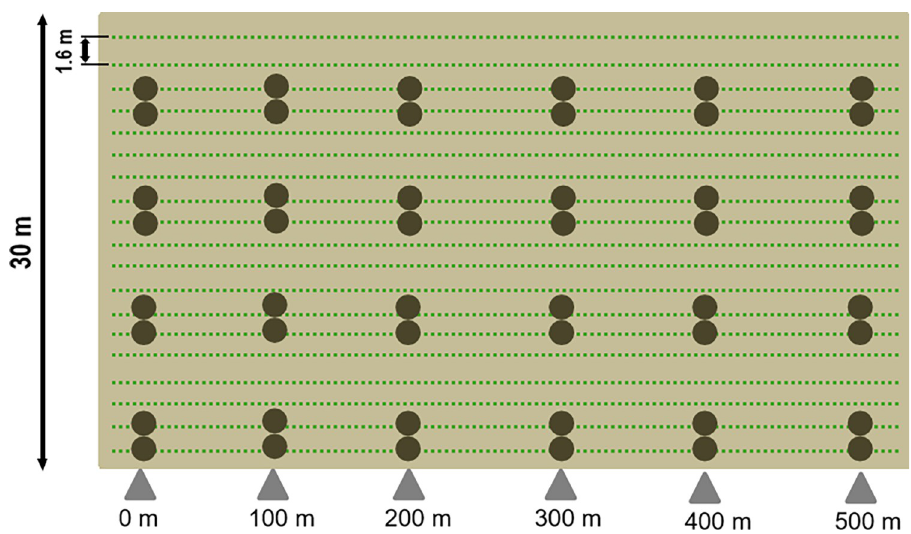
Fig 1. Schematic design of an exemplary trial plot. A total of nine trial plots of different sites in the Spreewald region were analysed in 2017, 2018 and 2019. All trial plots were analysed according to the sampling design shown here. Trial plot dimensions were 500 m long and 30 m wide with 17 to 19 rows of planted cucumbers (green dotted line) included. Transects with GPS-coded sample points (brown dots) were established every 100 m. placed on plant rows and maintained during growing season (Fig 1). Samples from two adja- cent sample points were combined into one mixed sample. There were a total of eight regularly spaced sampling points on a transect, resulting in 48 mixed soil samples on one plot.